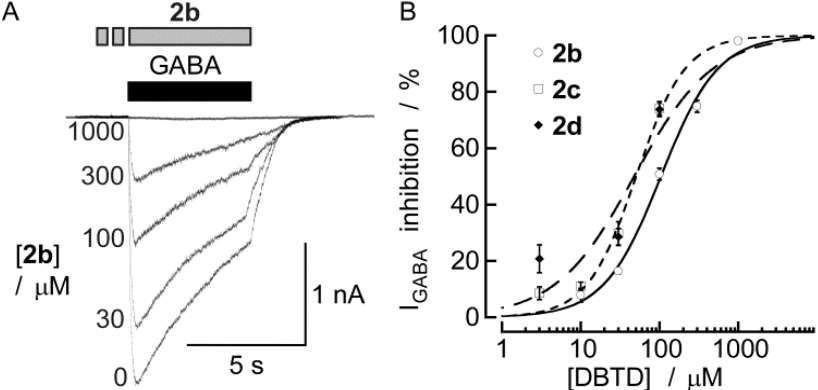
Figure 5. DBTDs inhibited I in a concentration-dependent manner. ( A ) Representative GABA recordings from a myenteric neuron in the presence of various concentrations of 2b , I GABA which was added 3 min before GABA application. ( B ) Concentration—response curves for the effects of the DBTDs on the amplitude of I . The lines indicate fits to the GABA experimental data using a two-parameter logistic function, [22] assuming an inhibition of 100%. Each data point represents the mean ± SEM from 3–12 individual